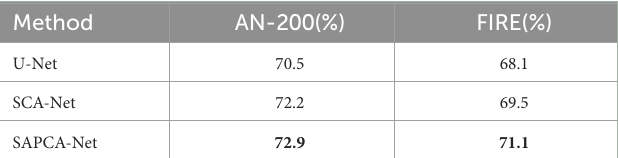
TABLE 2 The evaluation results of methods with different network settings on AN-200 and FIRE datasets. Method